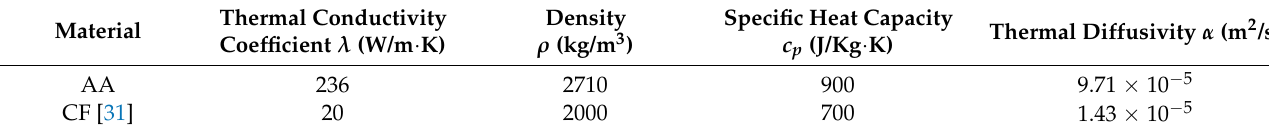
Table 1. Thermophysical properties of aluminum alloy and carbon